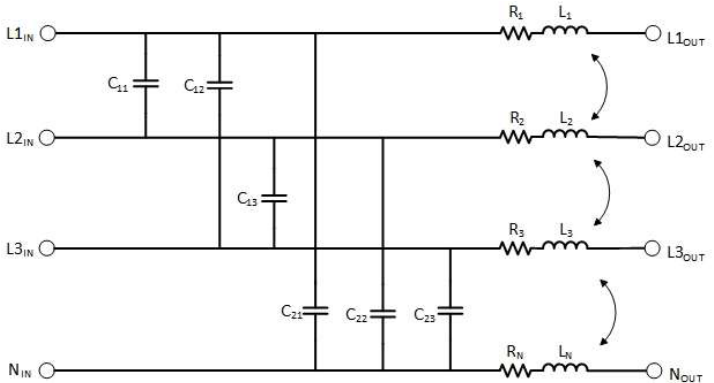
Figure 10. Model of a low-voltage cable line operating in the TN-C system.